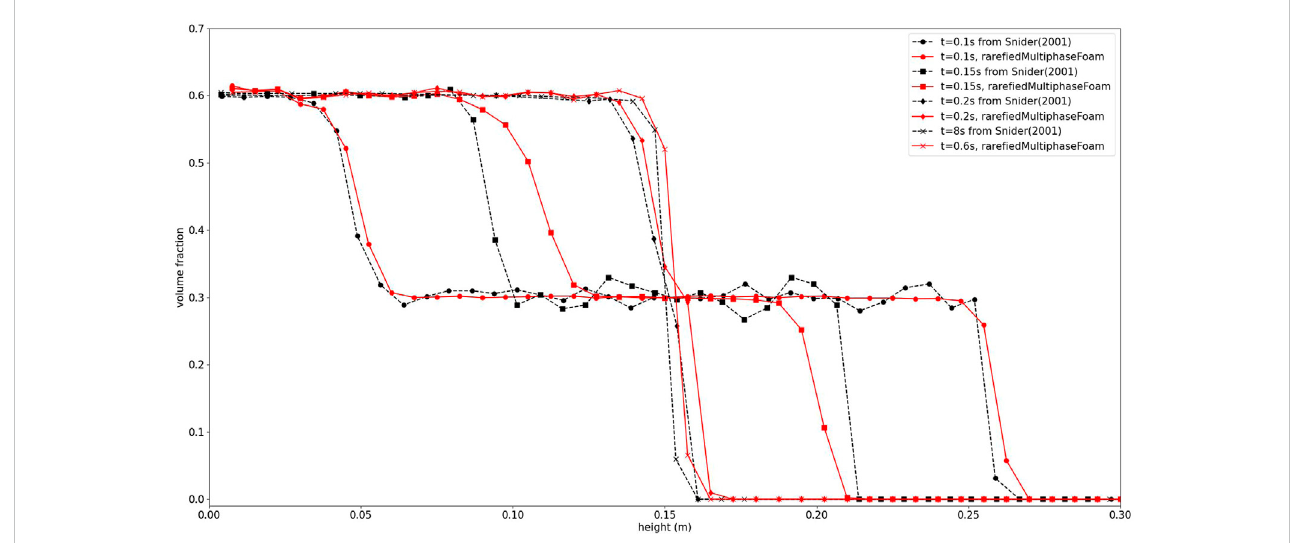
Solid phase volume fraction with time. Comparison between the result from Snider (2001) and that from rare fi edMultiphaseFoam. Figure updated.